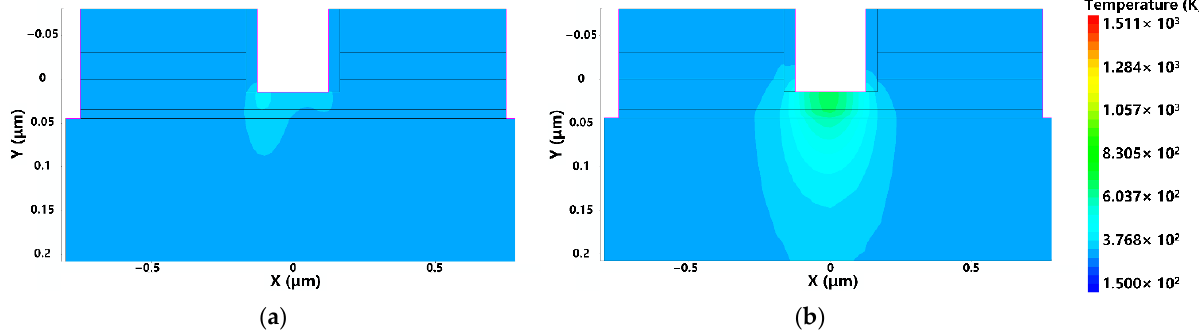
Figure 7. The distributions of current density: ( a ) 0.7 ns; ( b ) 1.0 ns; ( c ) 1.2 ns; ( d ) 1.4 ns.